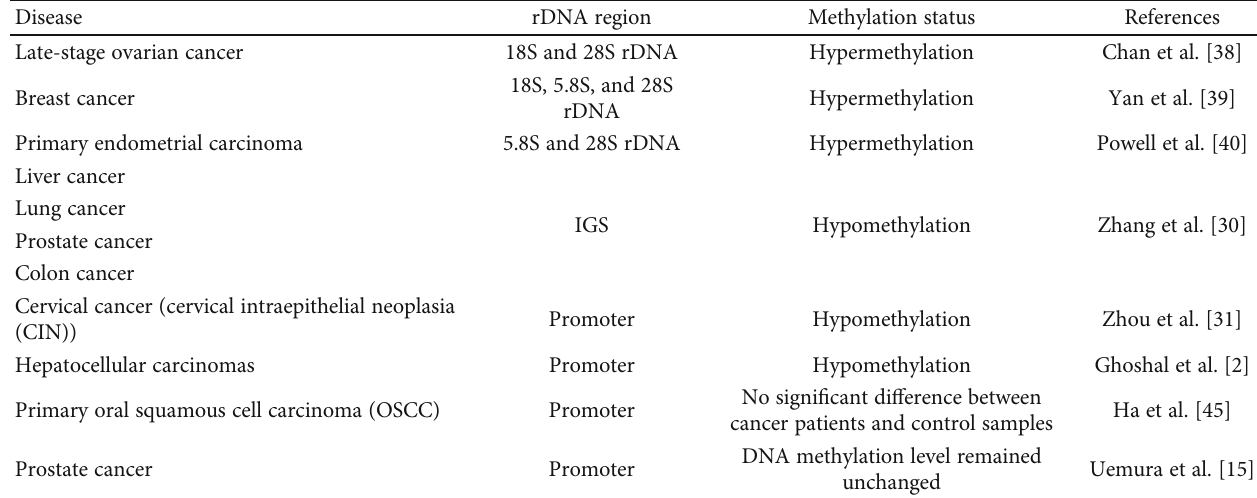
Table 1: Summary of rDNA methylation in selected cancer